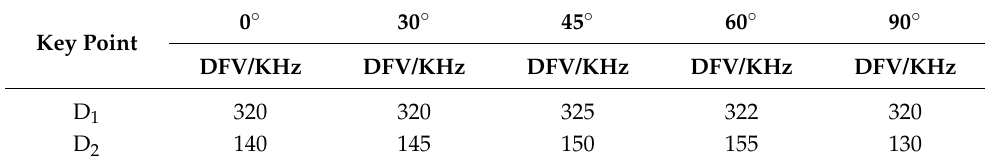
Table 8. Dominant frequency values of key point for different bedding angles under dry state.